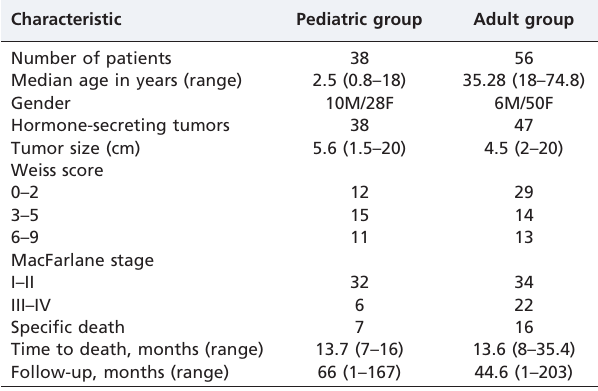
Table 1 - Clinical data from 94 patients with adrenocortical tumors.